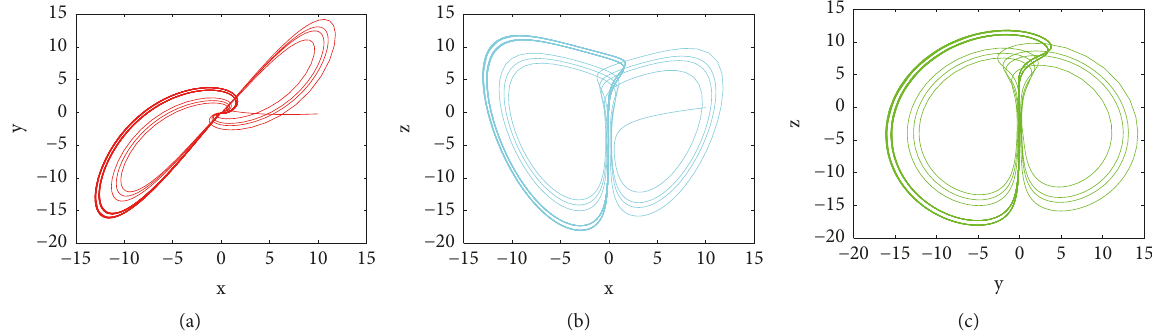
Figure 9: Phase portraits of the 3D chaotic Lorenz type system for Experiment 3 at 𝑐 = 2 : (a) (𝑥,𝑦) -plane; (b) (𝑥,𝑧) -plane; (c) (𝑦, 𝑧) -plane.